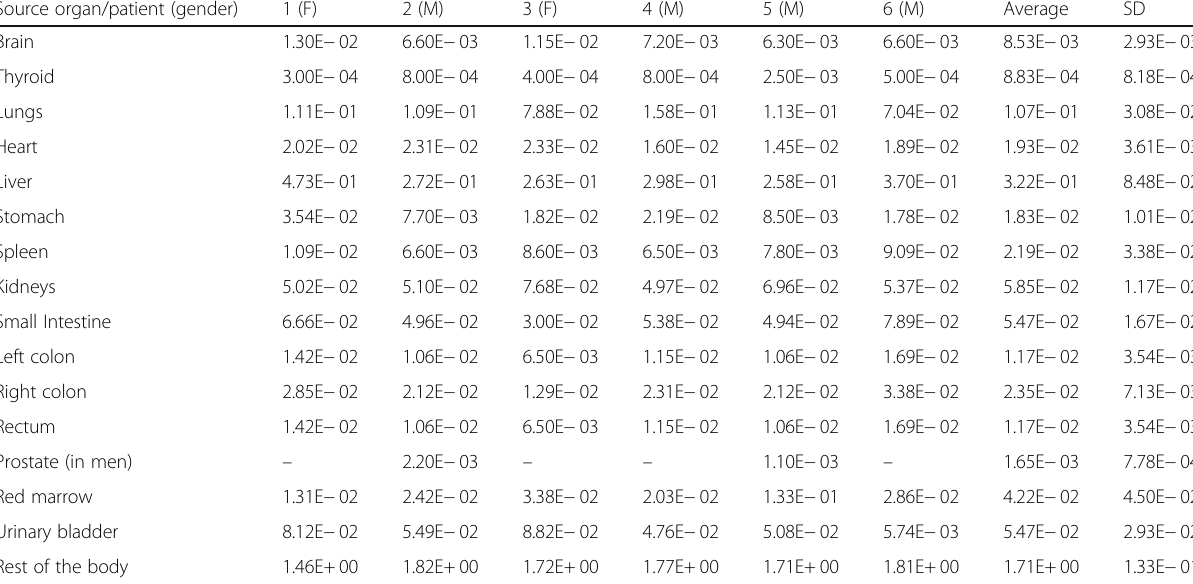
Table 2 Time-integrated activity coefficients (TIAC in units of MBq h/MBq) for source organs considered in the dosimetry study. Two male patients had surgical prostate resection before inclusion in this